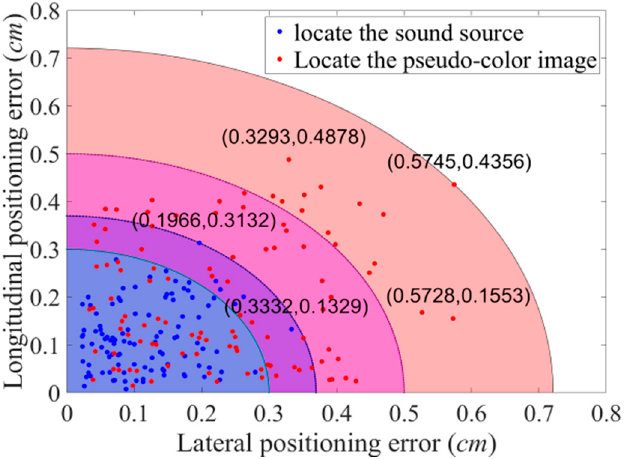
Figure 14. Experimental positioning result.